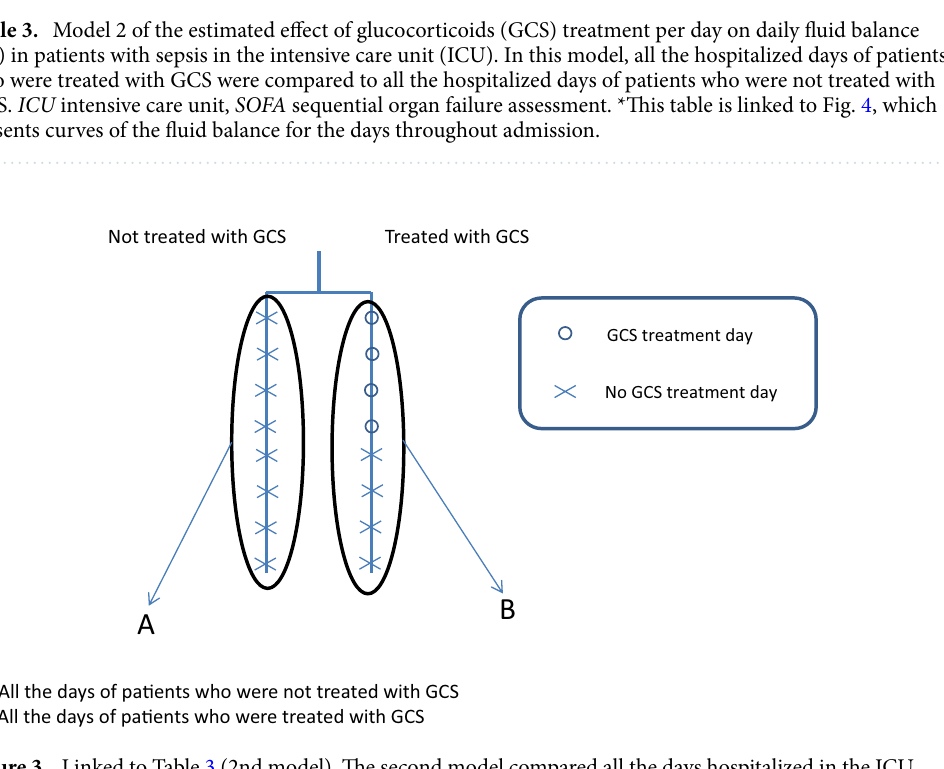
Figure 3. Linked to Table 3 (2nd model). The second model compared all the days hospitalized in the ICU, between patients not treated with GCS and patients who received GCS treatment.